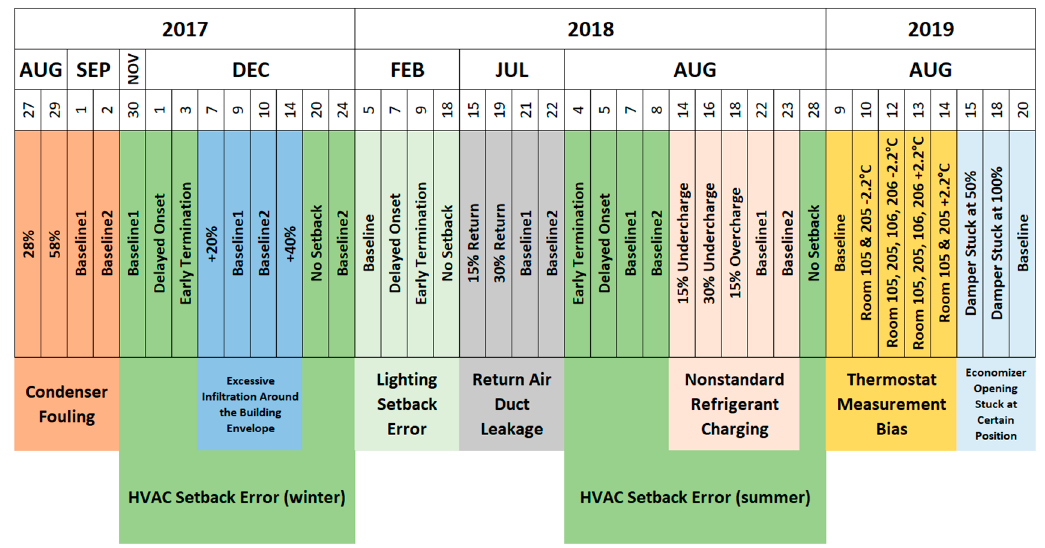
Figure 2. Tested dates of baseline and faulted scenarios for eight different faults.